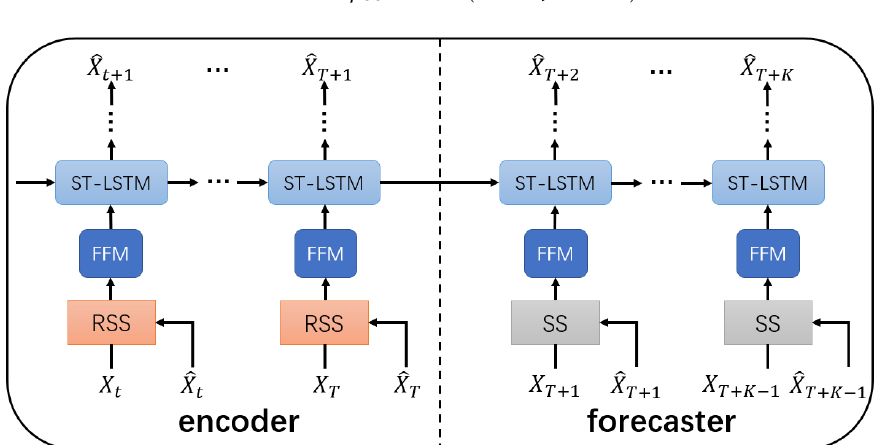
Figure 3. The RSS strategy in encoder and the SS strategy in forecaster. 𝑋 𝑡 is the observed image at ˆ X t + 1 is the predicted image at the next timestep t timestep 𝑡 and 𝑋̂ 𝑡+1 is the predicted image at the next timestep 𝑡 + 1 . timestep t and